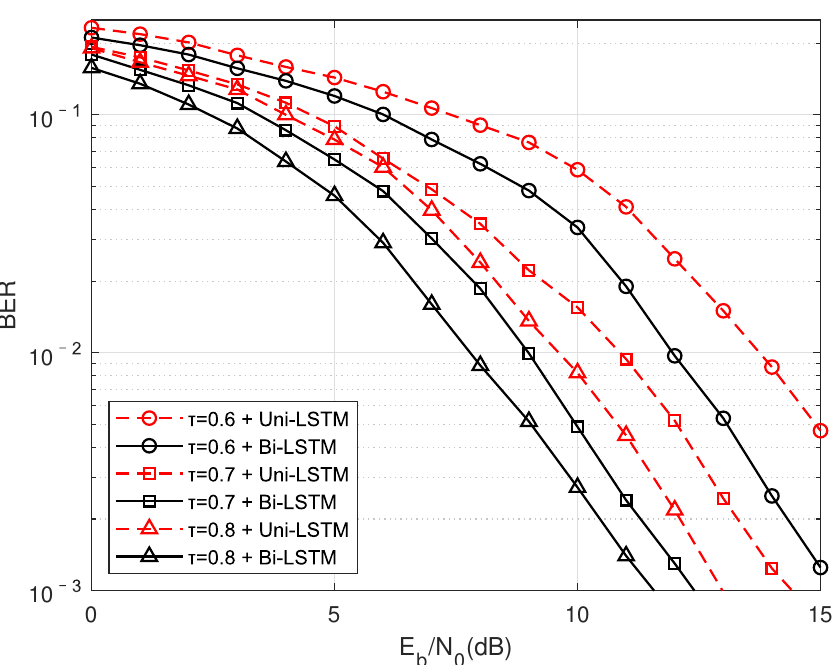
Figure 14. Under the TU channel moving speed of 60 km/h, compare the performance of unidirec- tional LSTM (Uni-LSTM) and bidirectional LSTM (Bi-LSTM).